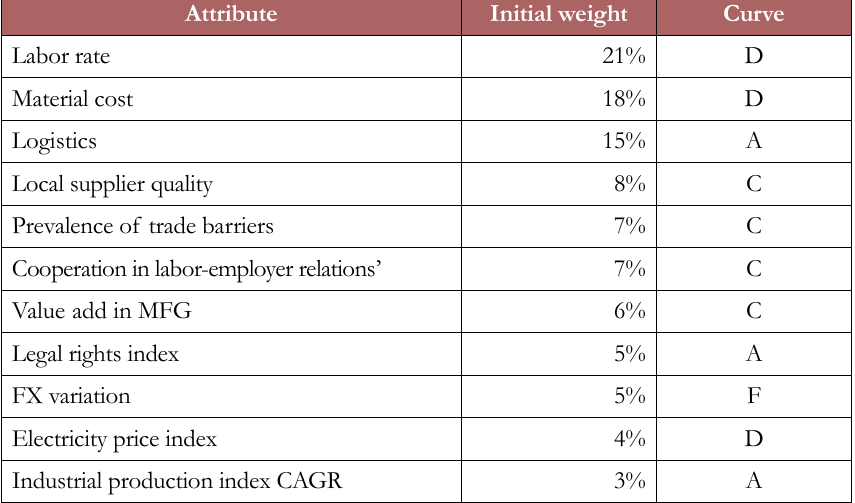
Table 3. Final factors, weights, and